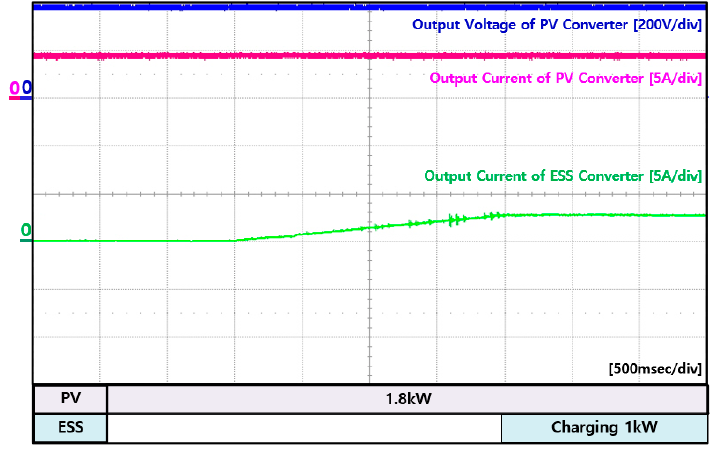
Figure 36. Experiment waveforms of PV converter and ESS converter in mode 7.